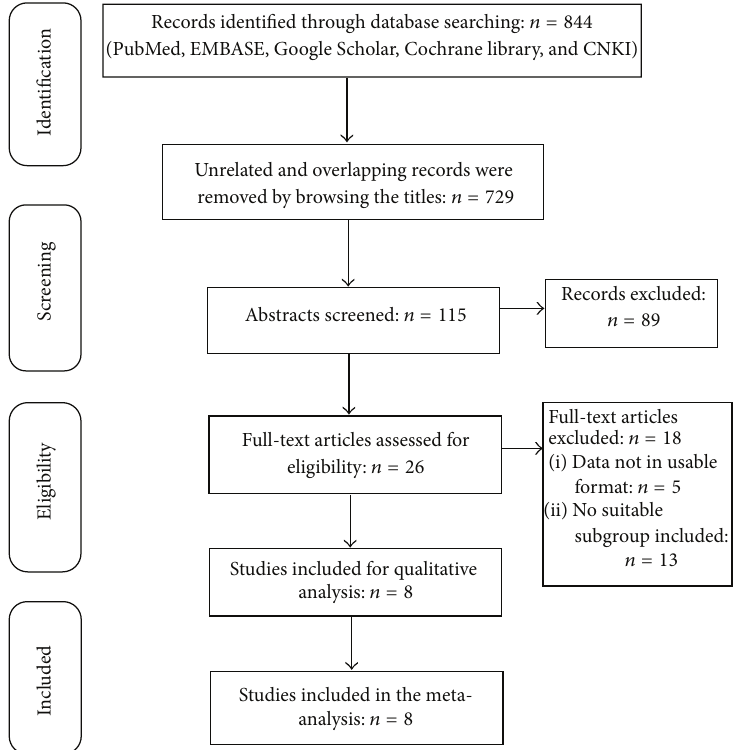
Figure 1: Study selection flowchart.